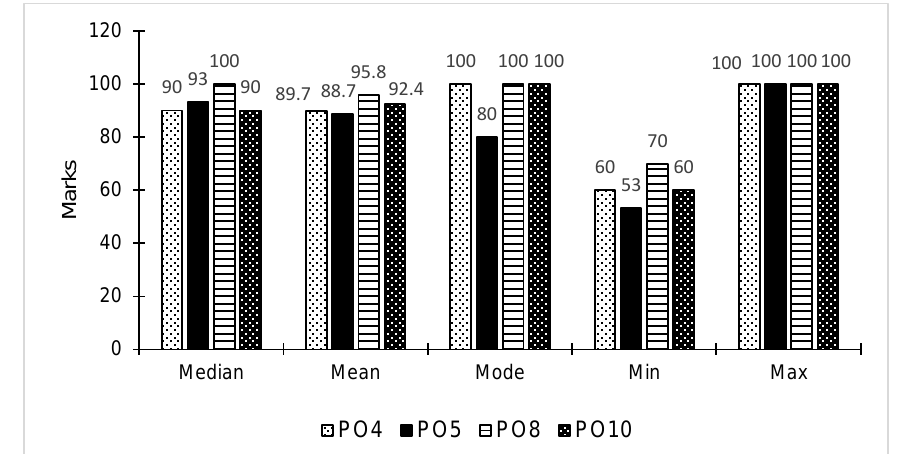
Fig. 3. Descriptive analysis for each